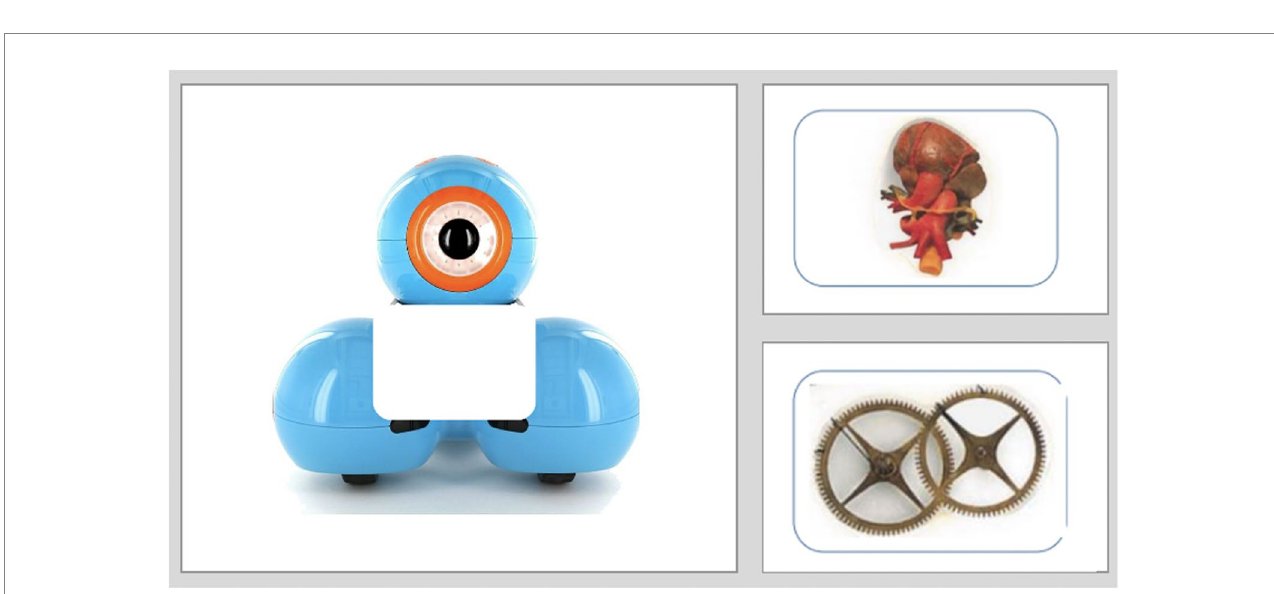
FIGURE 2 A Dash robot trial from the Naive Biology task. Children selected a biological (i.e., top in this example) or mechanical inside (i.e., bottom in this example) for the robot. Dash image (left) reproduced with the permission of Wonder